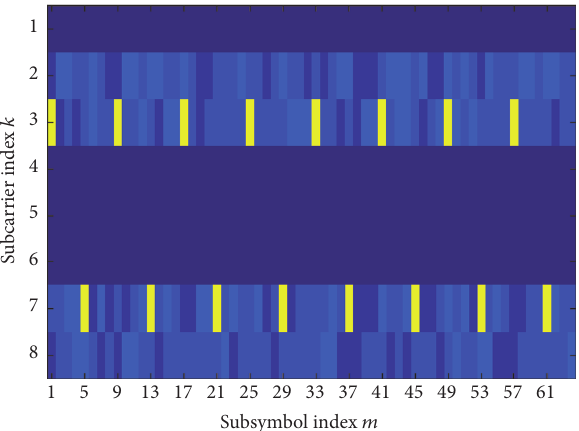
Figure 8: Pilot symbol insertion for GFDM symbol ( 𝐾 = 8,𝑀 = 64 ).